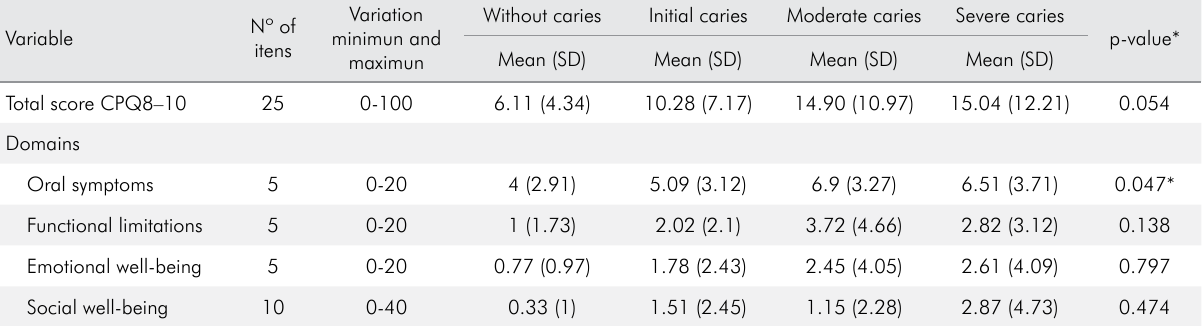
Table 2. Mean and Standard Deviation of the total and domain scores of the Child Perceptions Questionnaire according to the different stages of dental caries severity. Pelotas, RS, Brazil (n = 119).